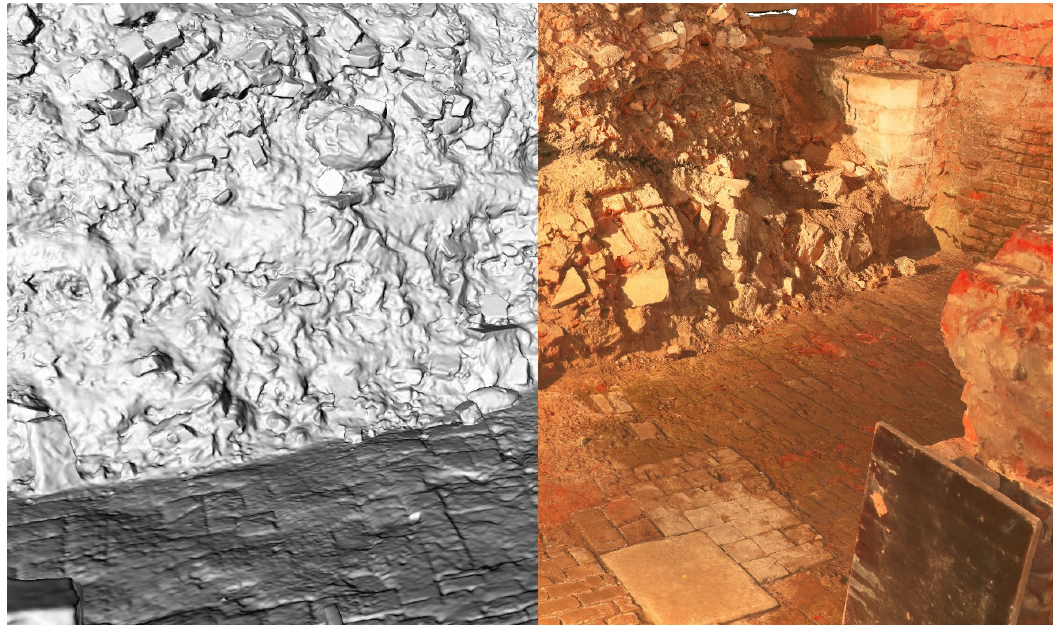
Figure 18. Mesh from the Aula Magna—with (right) and without texture (left).